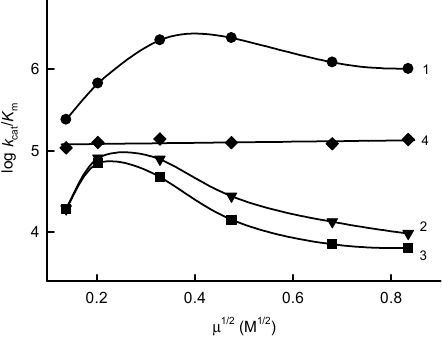
Figure 4. Effects of the ionic strength on the reactivity of PfFNR towards the electron acceptors. The dependence of log k cat / K m for ferricyanide (1), Fe(EDTA) − (2), benzylviologen (3) and tetramethyl-1,4-benzoquinone (4) on the ionic strength of the phosphate buffer at pH 7.0 is shown .